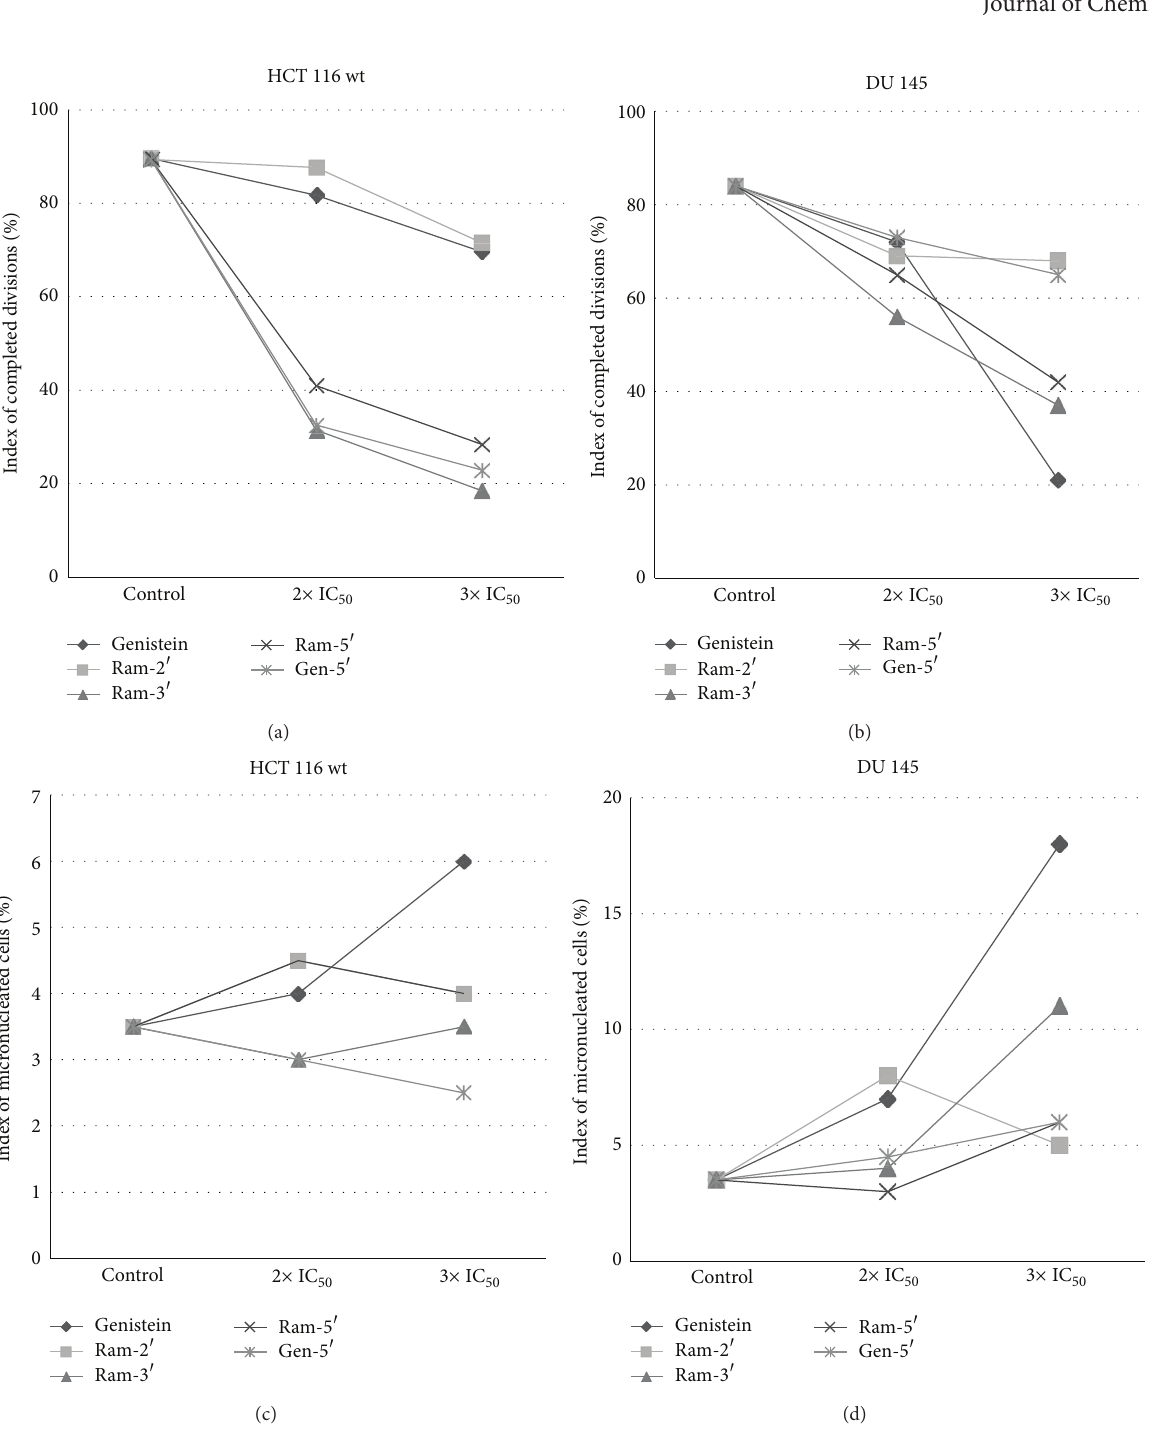
Figure6:Indexofbinucleatedcellsrepresentingcompletednucleardivisionscountedafter24 htreatmentwithgenisteinoritsC4 󸀠 -substituted derivatives used at concentrations corresponding to 2x IC 50 and 3x IC 50